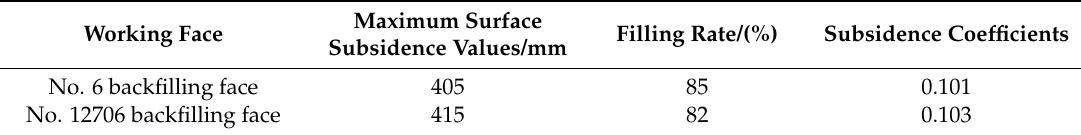
Table 2. The value of surface subsidence situations in the filling region.